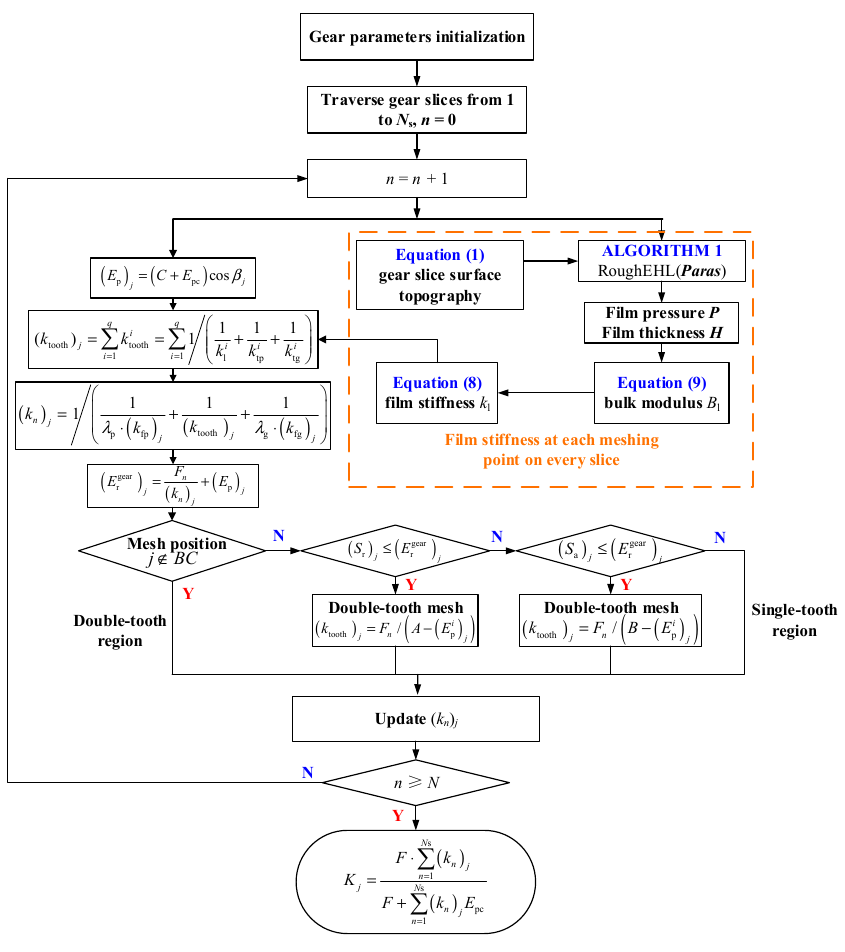
Figure 11. Flow chart of calculation of TVMS under EHL conditions with 3D surface topography.